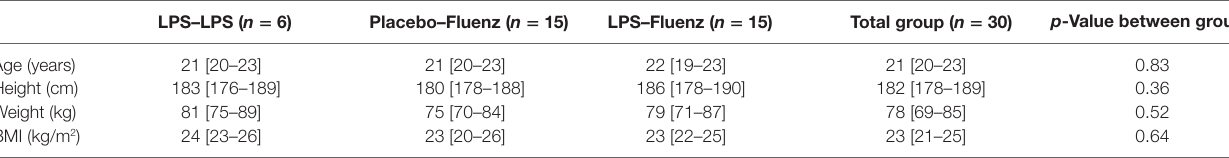
Table 1 | Demographic characteristics of the 30 subjects who participated in the study, including the 6 subjects from our previous study, in which subjects received lipopolysaccharide (LPS) twice.